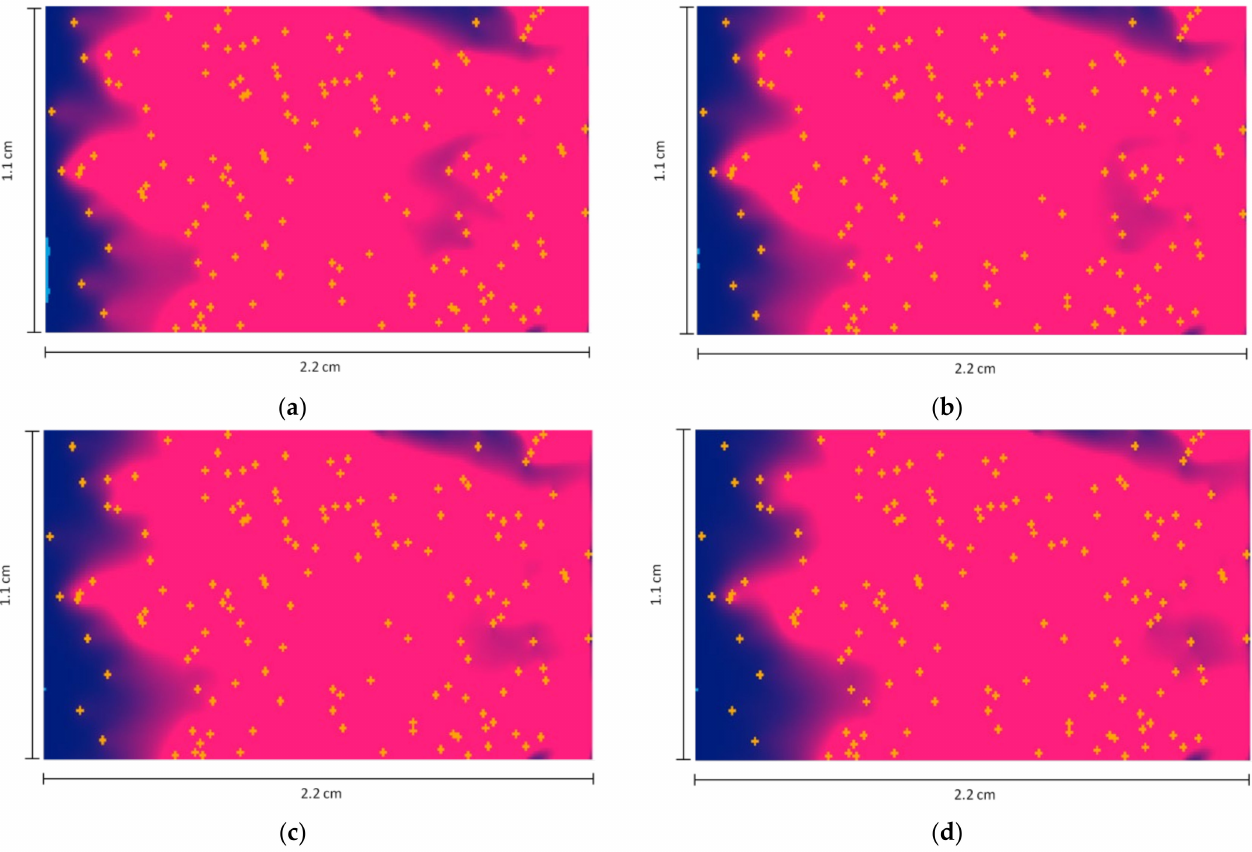
Figure 16. Visualization of the melatonin concentration distribution in the model nasal cavity during the deposition of chitosan-based aerogel particles at different time points: ( a ) 3.75 min; ( b ) 4.5 min; ( c ) 5.25 min; ( d ) 6 min. Color gradient from purple to blue shows the number of API particles in cell from high to low,